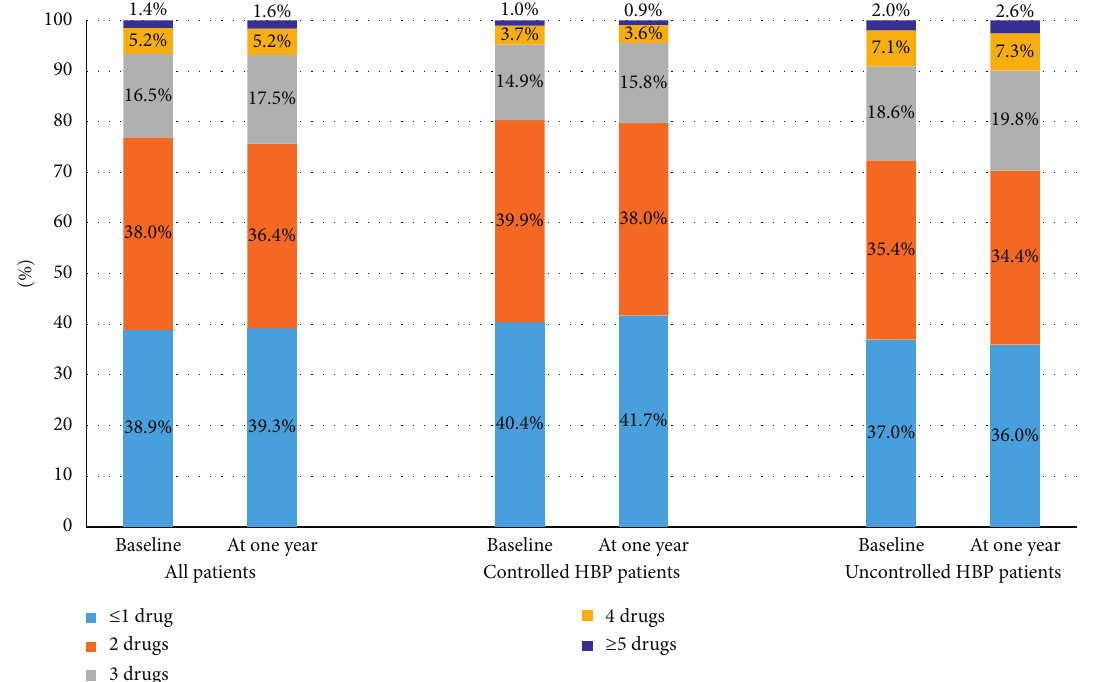
Figure 1: Number of antihypertensive medications prescribed at baseline and at one year of follow-up between the controlled and uncontrolled HBP groups at one